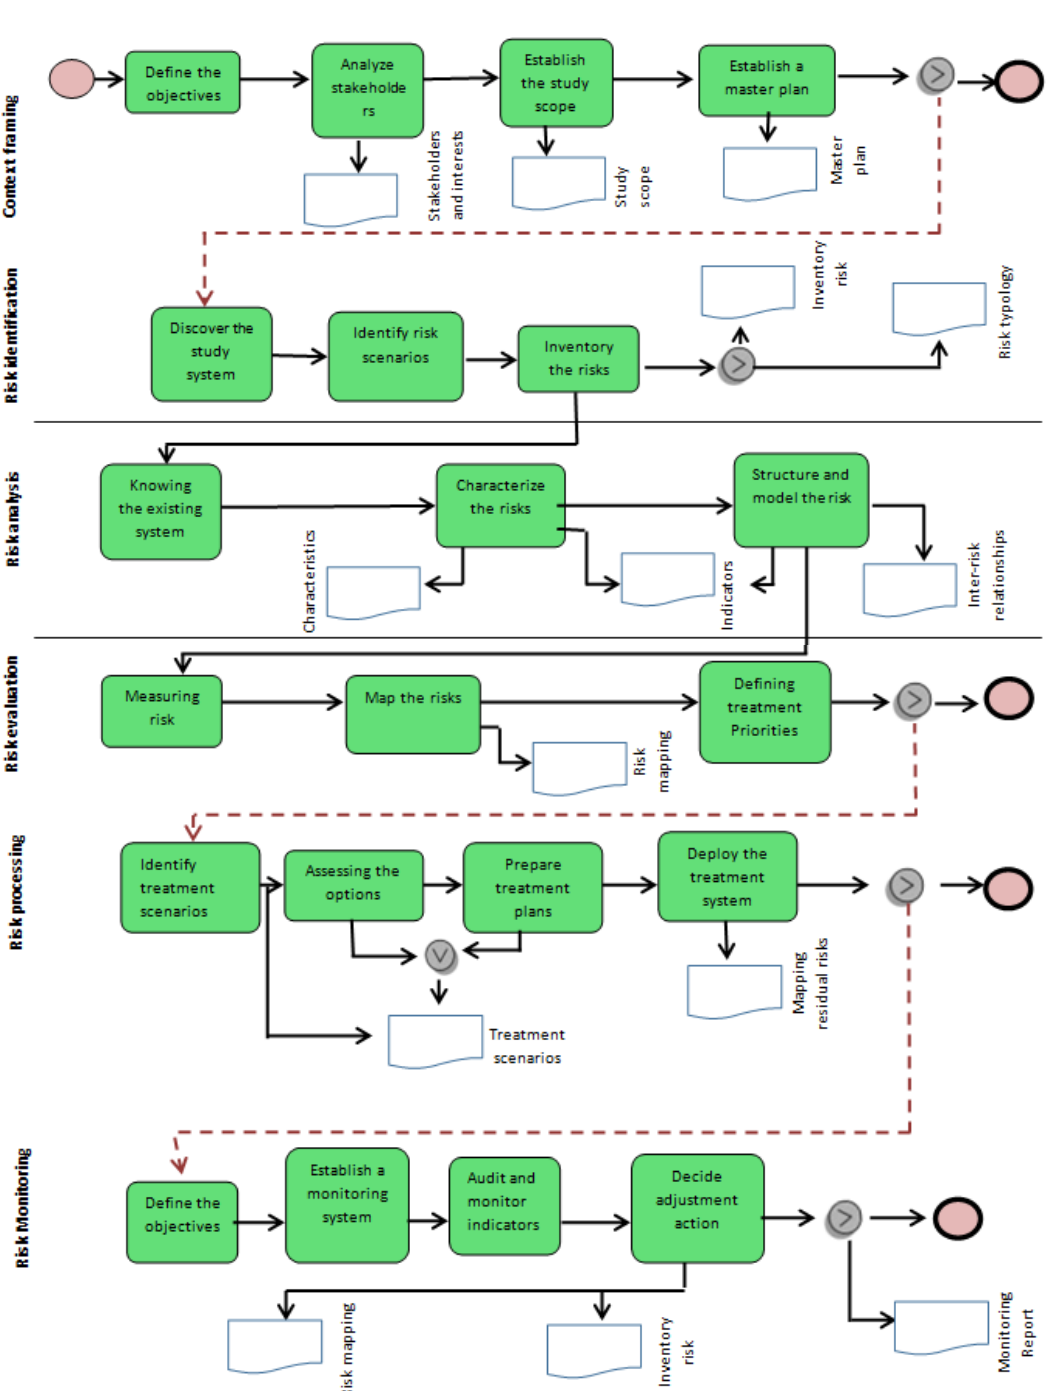
Figure 2. The modeling of the risk management